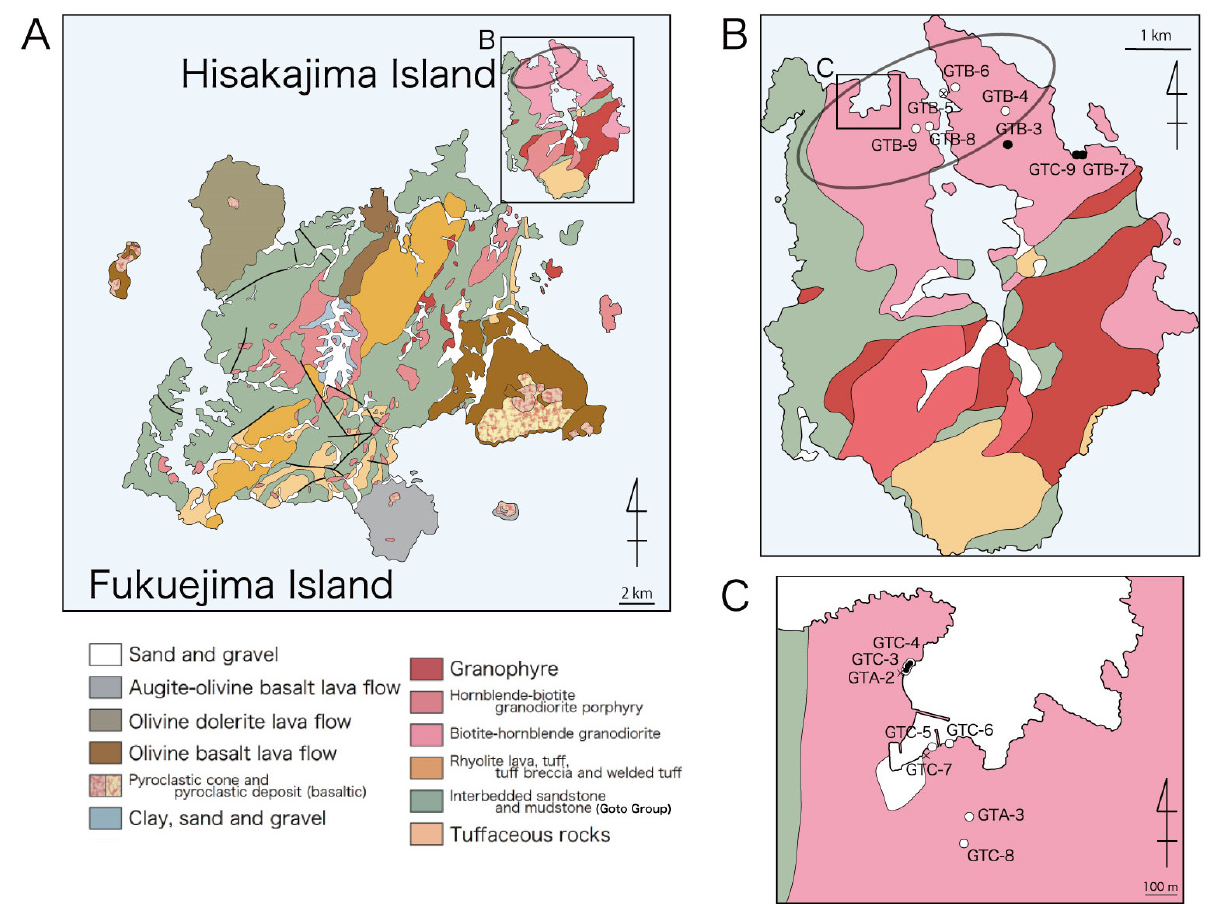
Figure 2. Geological Map showing the sample localities—( A ) Hisakajima and Fukuejima Islands; ( B ) Hisakajima Island; and ( C ) northwestern coastal area of Hisakajima Island. The geological map is adopted from Matsui and Kawada (1986) [17]. Solid circles—GD group samples. Open circles—HFG group samples. Cross mark—dike sample. The large circle indicates the distribution of the HFG group rocks. At sites GTA-2, GTC-3, and GTC-4, GD Group rocks occur as enclaves in the HFG Group rocks.